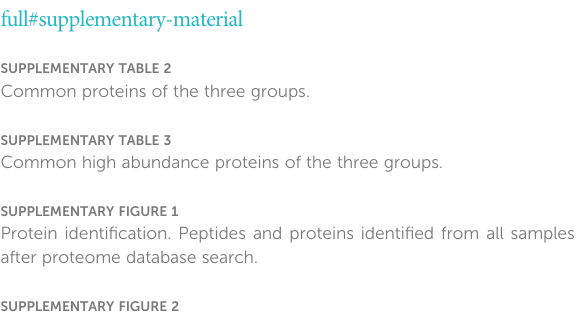
after proteome database search.